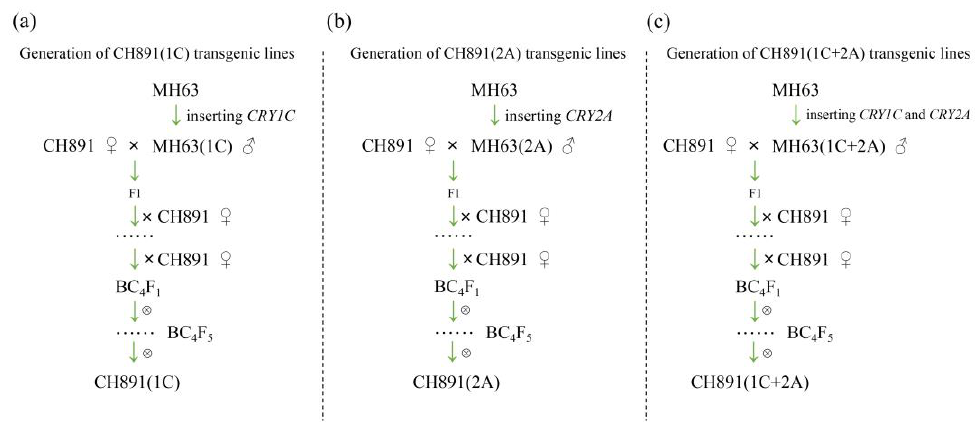
Figure 1. The development of transgenic restorer lines: ( a ) CH891(1C) was produced by backcross- ing MH63(1C) as a donor parent with CH891 as a recurrent parent; ( b ) CH891(2A) was produced by backcrossing MH63(2A) with CH891, and ( c ) CH891(1C+2A) was produced by backcrossing MH63(1C+2A) with CH891.